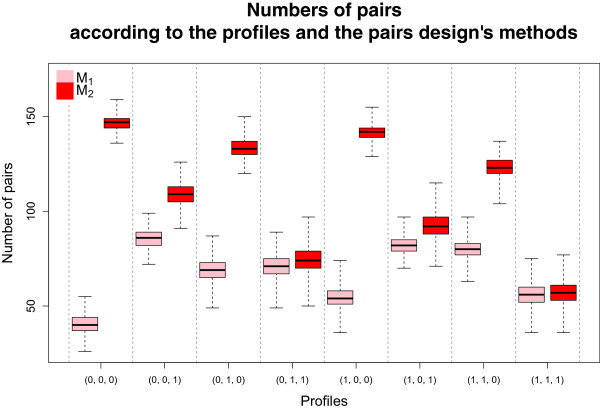
Number of pairs. Distribution of the number of pairs according to the profiles and to the matching methods M1 and M2. Results obtained with the increasing then decreasing HR(t) configuration, without censoring and with β12′=(−0.2,−0.4,−0.8), β13=−β12 and β23=−β13.